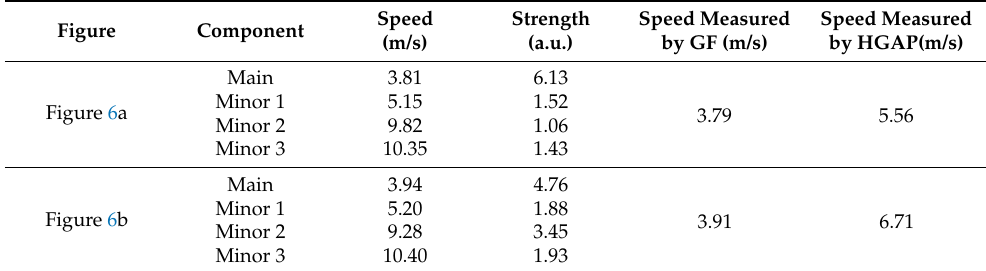
Figure 6. The spectra processed by the HGAP and the GF. ( a ) The processing result of spectrum 1; ( b ) The processing result of spectrum 2.